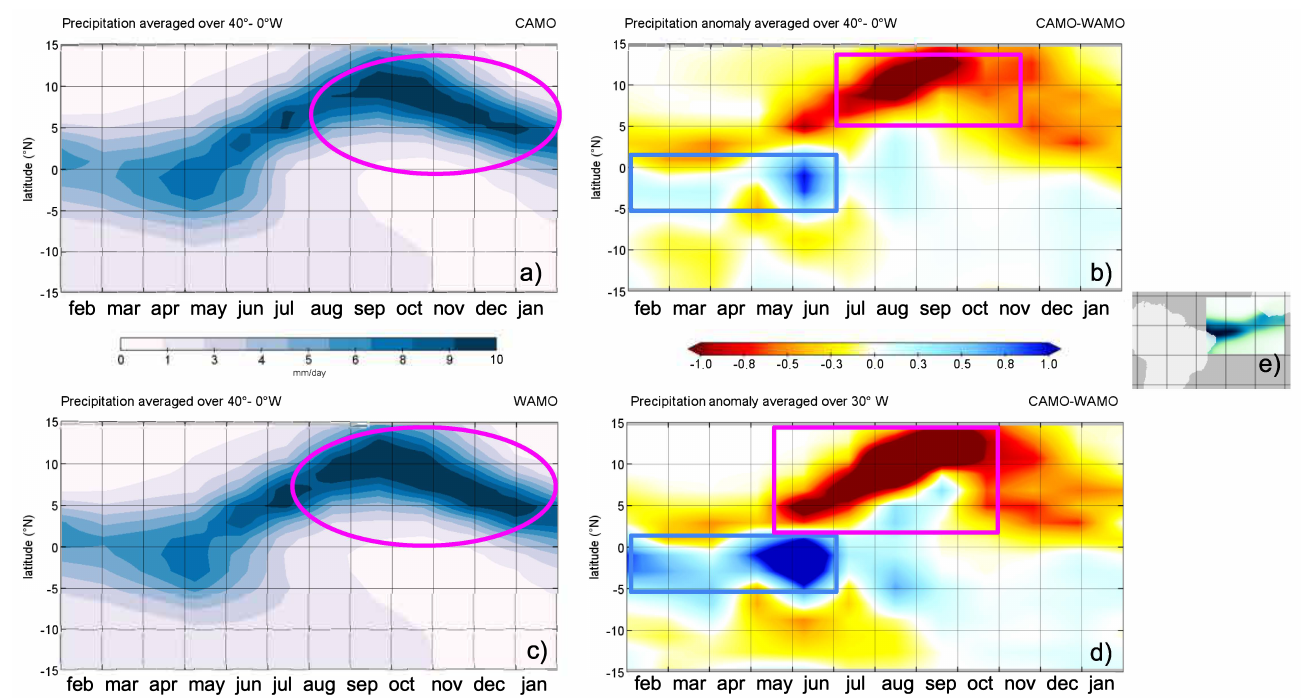
Figure 6. Annual cycle of precipitation for the cold Atlantic Multidecadal Oscillation (CAMO) ( a ) and the warm Atlantic Multidecadal Oscillation (WAMO) ( c ) experiments averaged over 40 ◦ W–0 ◦ , and their differences averaged over the whole longitudinal band ( b ) of the Atlantic Intertropical Convergence Zone (ITCZ) section ( e ) (15 ◦ N–15 ◦ S; 40 ◦ W–0 ◦ ) and only at 30 ◦ W ( d ), where the precipitation anomaly was the highest.